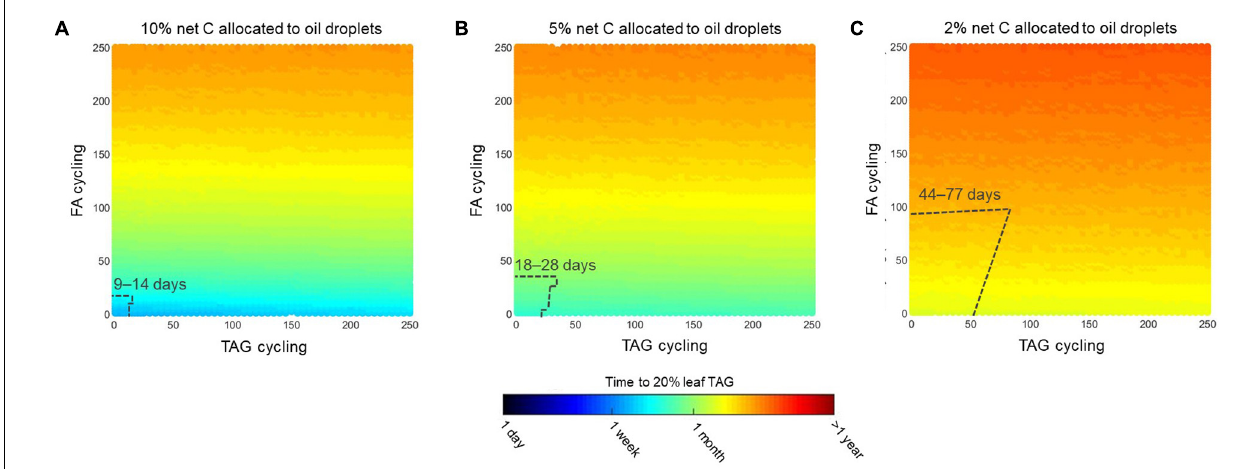
FIGURE 7 | Effect of futile cycles at fixed carbon allocation ratios. Subsets of simulations presented in Figure 6 to illustrate how TAG and FA futile cycling together lead to changes in the time needed to accumulate 20% (w/dw) TAG in mature Sorghum bicolor leaves when (A) 10, (B) 5, or (C) 2% of net carbon is allocated to oil droplets. Colors indicate the expected time on a log scale. Dashed lines indicate a region close to the origin (0, 0) within which maximum flux limits in lipid metabolism are not exceeded. We set these flux limits based on a scenario where leaf biomass synthesis was maximized. In the delimited region simulations, the total fatty acid synthesis rate was less than 10-fold the synthesis rate in the growing leaf scenario. The range of days until 20% TAG is reached in the delimited region is given. Cycling units are mol TAG synthesis per mol TAG accumulated in oil droplets (TAG cycling) and mol fatty acid synthesis per mol fatty acid stored in oil droplets (FA